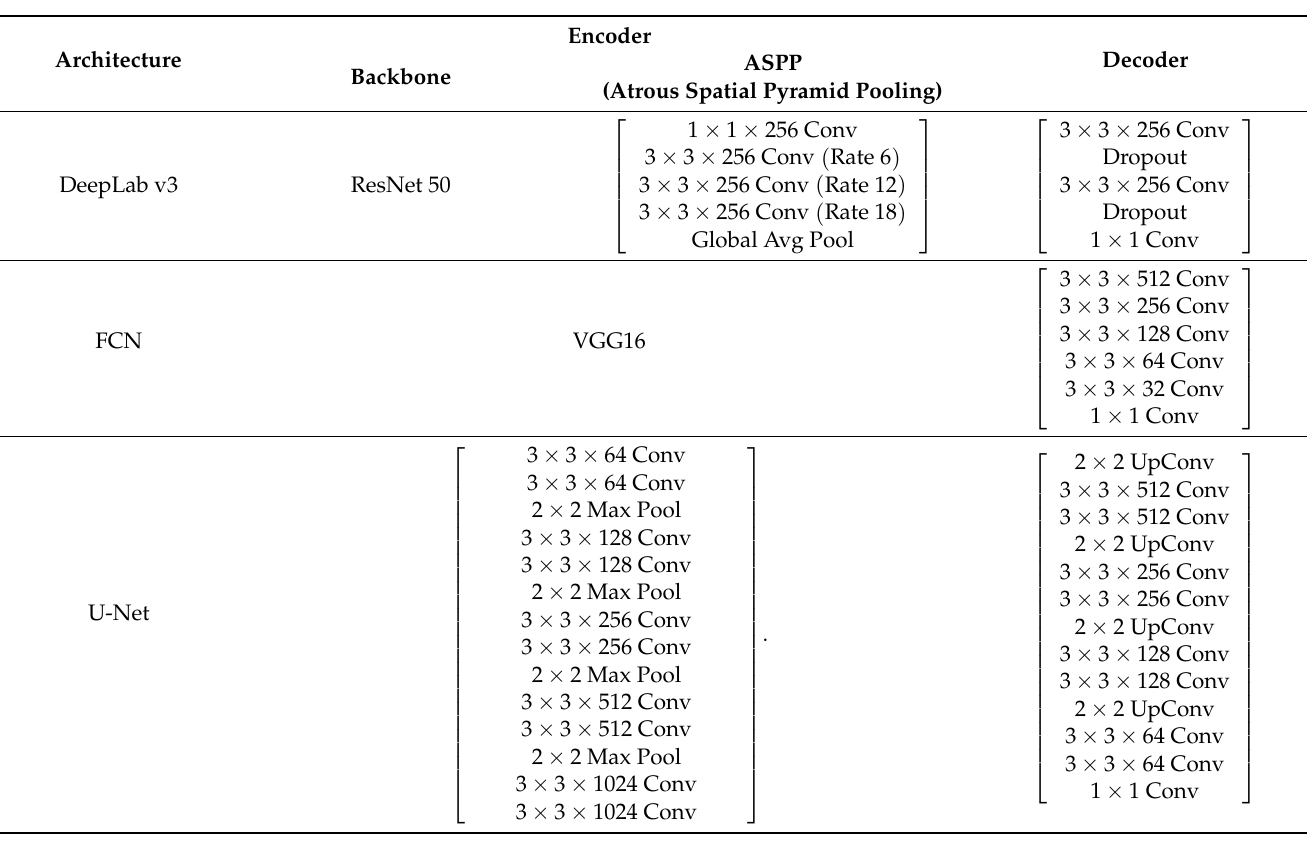
Table 1. Description of detailed configuration for each CNN architecture. [ · ] denotes a sequence of lay- ers. 3 × 3 × 256 Conv ( Rate 6 ) denotes a specific convolution layer; that is, kernel size: 3 × 3, channels: 256, dilatation rate: 6. Also, 2 × 2 UpConv consist of an up-sampling layer and 2 × 2 convolution. Encoder Architecture Decoder ASPP Backbone (Atrous Spatial Pyramid Pooling)